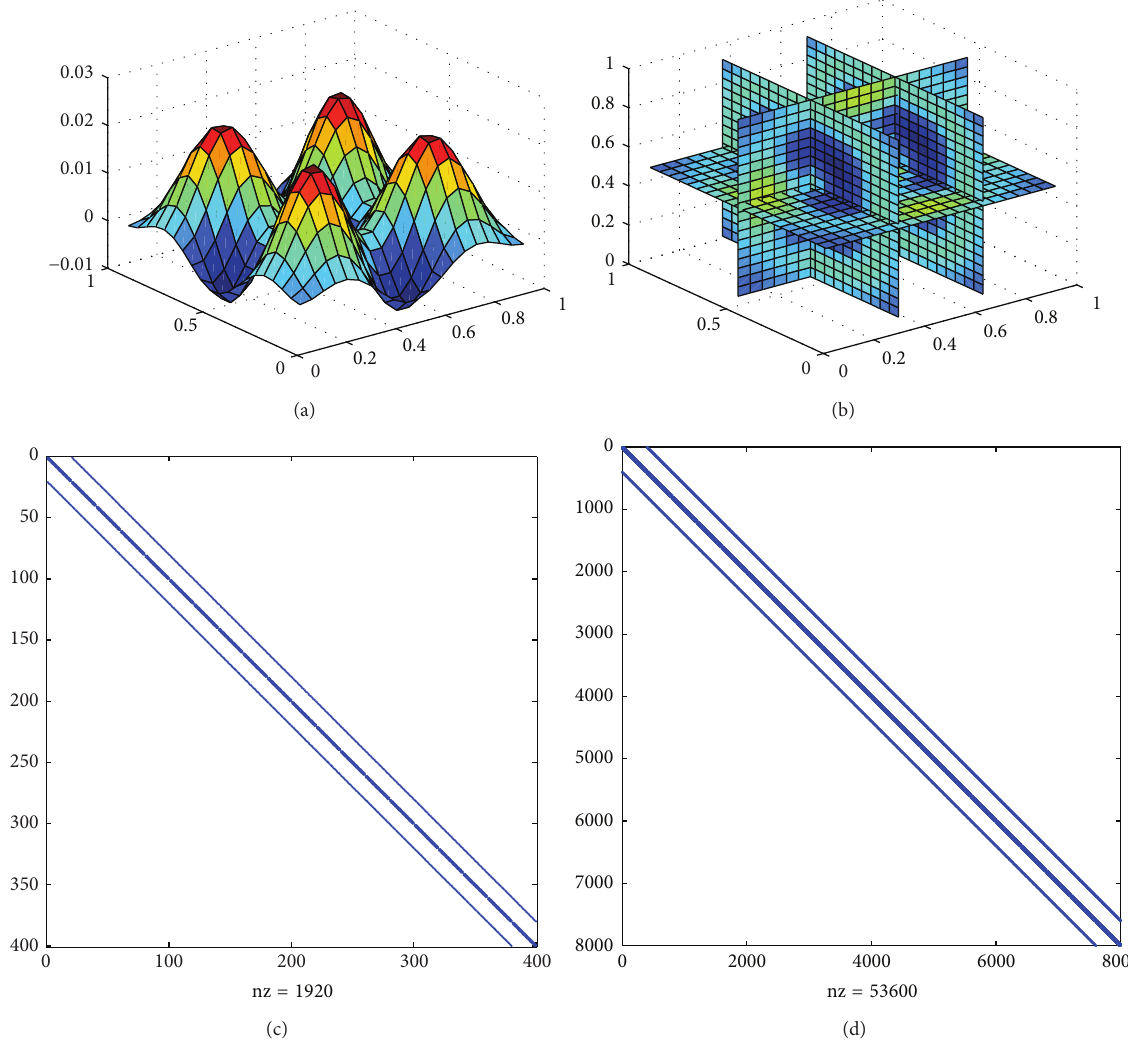
Figure 5: (a) The approximate solution for 2D. (b) The approximate solution for 3D. ((c) and (d)) The nonzero entries in block tridiagonal matrices, nz are the number of nodes in 2D and 3D